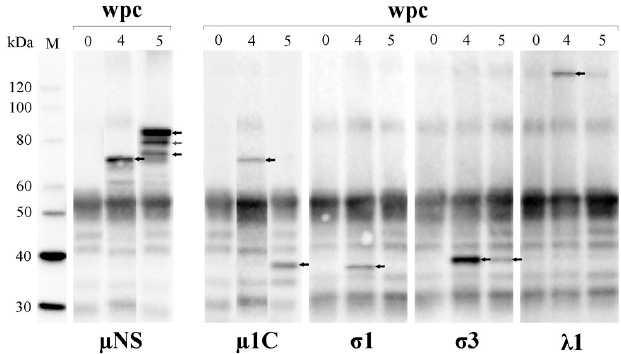
Figure 7. µ NS interacts with multiple PRV proteins. Pooled blood cell lysate ( n = 6) immunoprecipitated with µ NS-antiserum, followed by Western blotting with primary antibodies detecting µ NS, µ 1C, σ 1, σ 3 and λ 1 (arrows). M = molecular weight standard. Table 1. Identified piscine orthoreovirus (PRV) peptides following immunoprecipitation with anti- µ NS and mass spectrometry